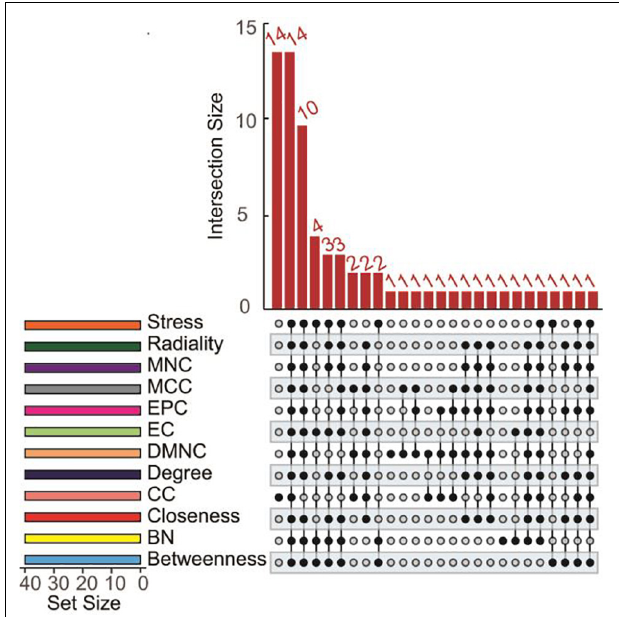
FIGURE 4 | UpSet diagrams of 12 topological algorithms determined by functional protein association PPI network analysis. The overlapping results of several topological algorithms including Degree, EPC, MNC, DMNC, MCC, and network centralities based on the shortest paths such as BN, EC, Closeness, Radiality, Betweenness, Stress and CC are shown.